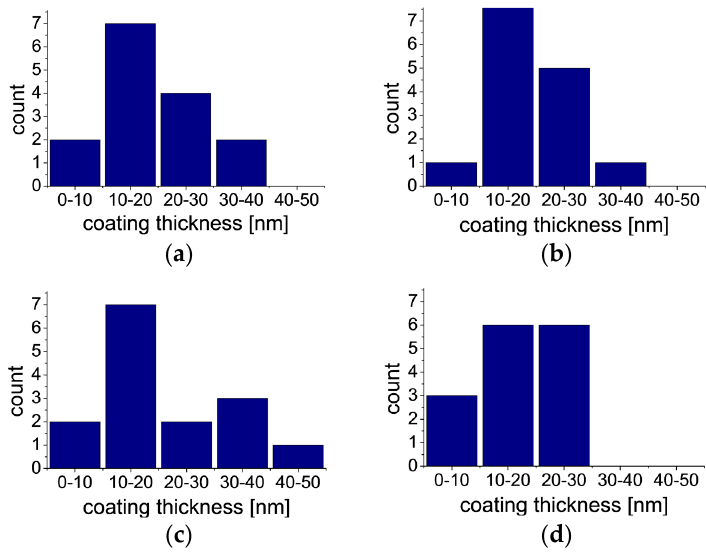
Figure 6. Histograms of measured thickness of coating 1( a ); coating 2 ( b ); coating 3 ( c ); and coating 4 ( d ).